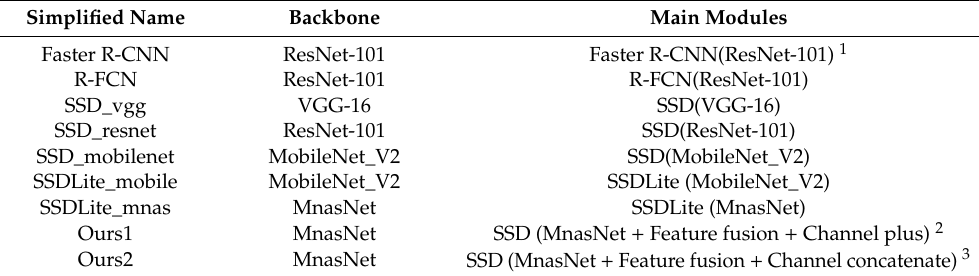
Table 2. Models used in the experiment. Backbone: The basic network used for feature extraction. Main Modules: The basic framework, backbone and feature fusion method of the